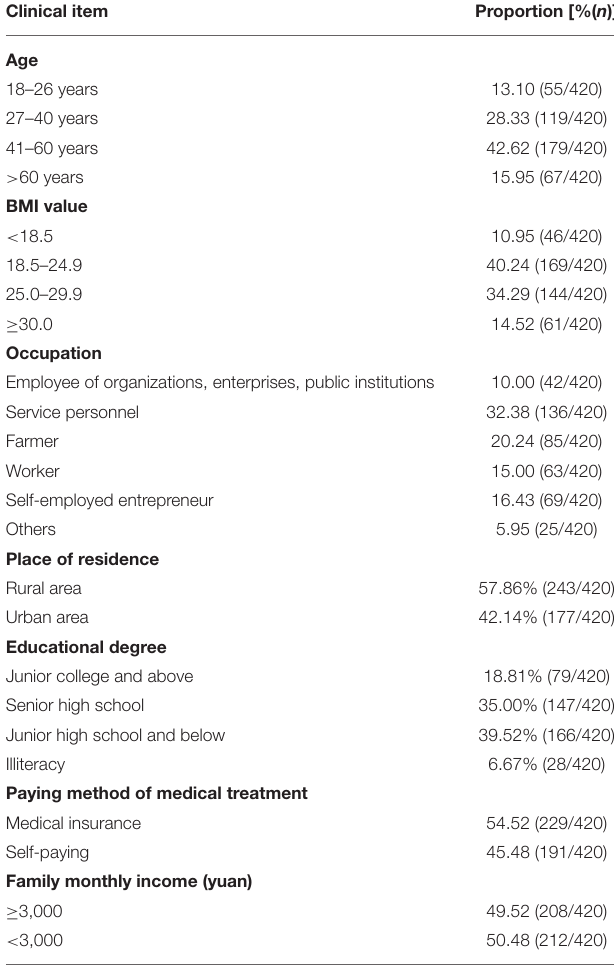
TABLE 1 | Clinical data of study subjects. Clinical